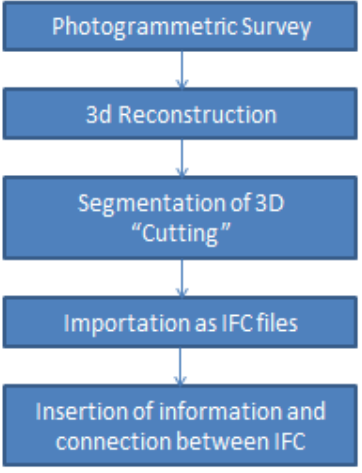
Figure 6. Reconstruction of Building Information Model